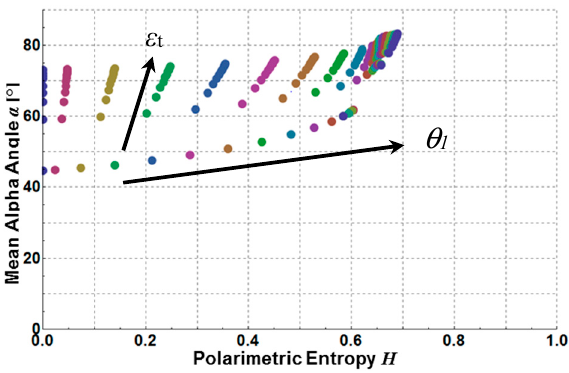
Figure 15. Sensitivity of polarimetric H − α scattering plane with roughness angle θ 1 ( ε s = 10, ε t = (2,42), L SXD = 1, ϕ = 0°, ω 1 = 35°). Color changes with increasing θ 1 .